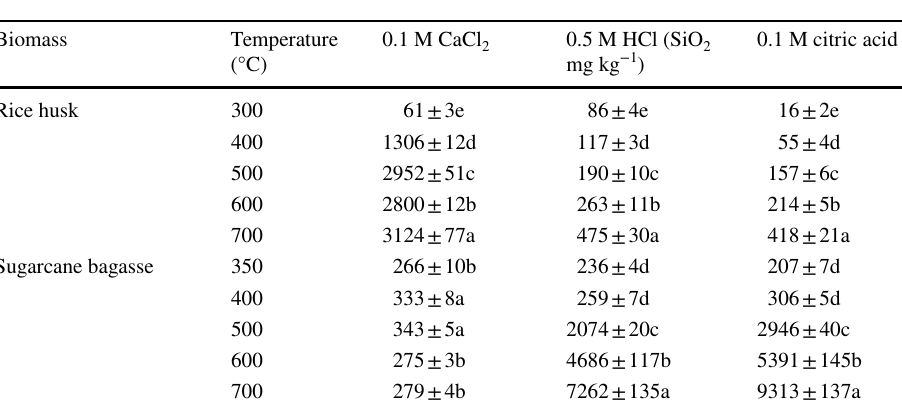
Table 4 The available silicon of the biomass at different pyrolysis temperature under different extraction